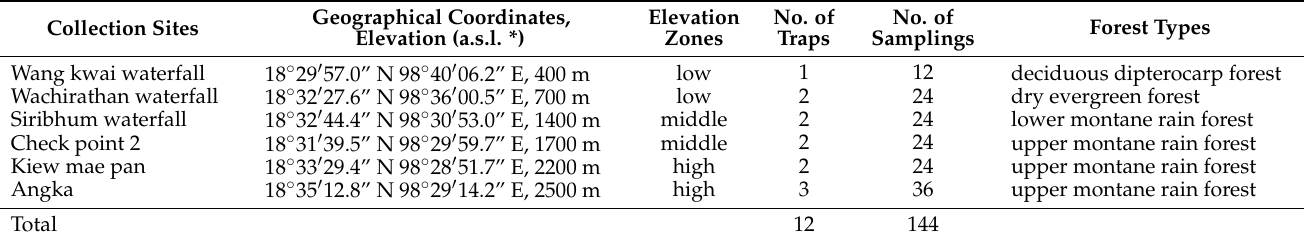
Figure 1. Map of six collection sites along elevational gradients in Doi Inthanon National Park, Chiang Mai province. Table 1. Physical data of six collection sites at Doi Inthanon National